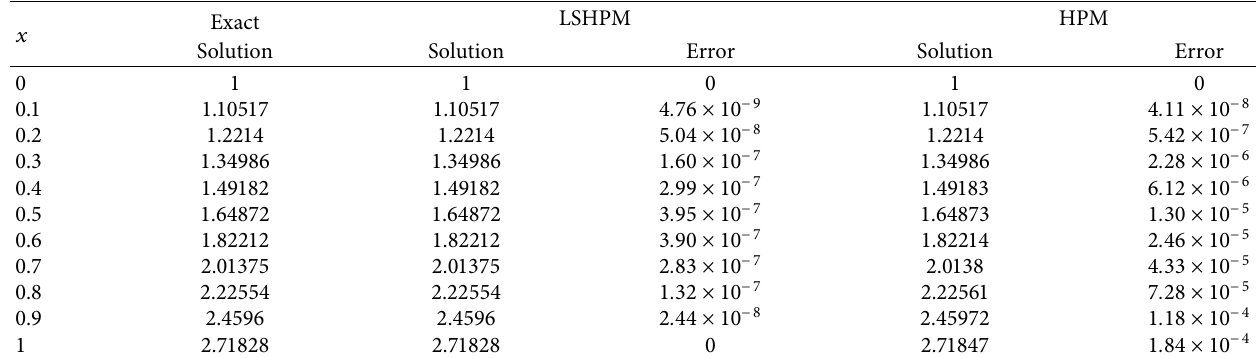
Table 12: Comparison of zeroth-order absolute error of LSHPM with HPM in Problem